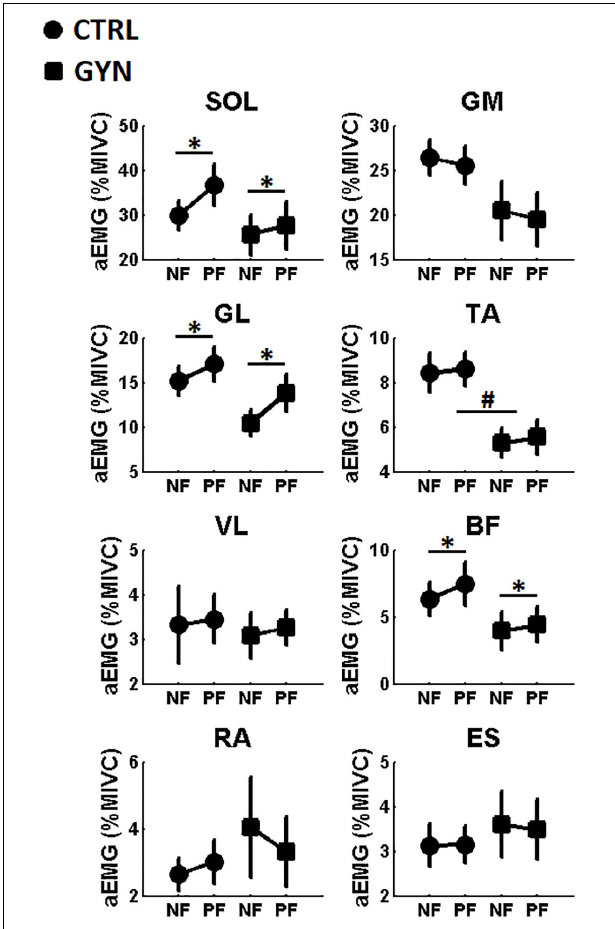
FIGURE 4 | Average amplitude of the EMG signal (aEMG, expressed in% of the Maximal Isometric Voluntary Contraction, MIVC) computed before (NF, no fatigue) and after (PF, post-fatigue) the fatiguing protocol. Values associated with the CTRL and GYN groups are represented by circles and squares, respectively. ∗ indicate a statistically significant effect of the fatigue factor, that is, significant differences between NF and PF ( p < 0.05). # indicate a statistically significant effect of the group factor, that is, significant differences between acrobatic gymnasts (GYN) and untrained controls (CTRL). TA: tibialis anterior , SOL: soleus , GL: lateral gastrocnemius , GM: medial gastrocnemius , VL: vastus lateralis , BF: and biceps femoris, ES : spinal erector and RA: rectus abdominis